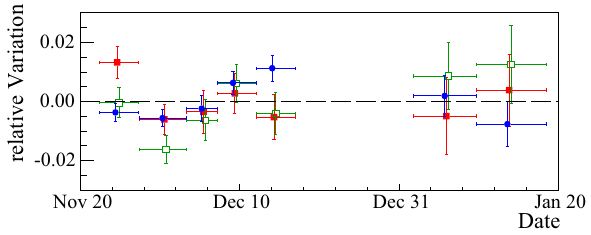
Fig. 25 The light and charge response is stable with time as demon- strated using the 164keV line from activated 131 m Xe. Shown are the relative variations of the light response (filled, blue points) and the charge response in various time intervals. The charge response is shown separately for both PMT arrays combined (red, filled squares) and the bottom array only (green, open squares). After applying all corrections, the response is stable to <